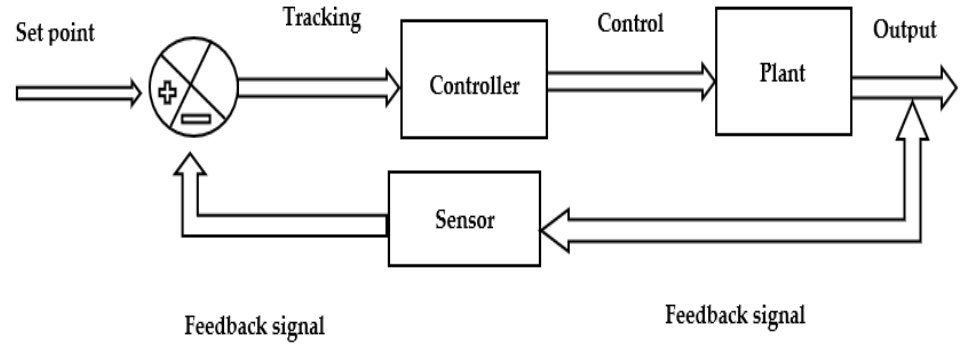
Figure 4. System block diagram with feedback control.